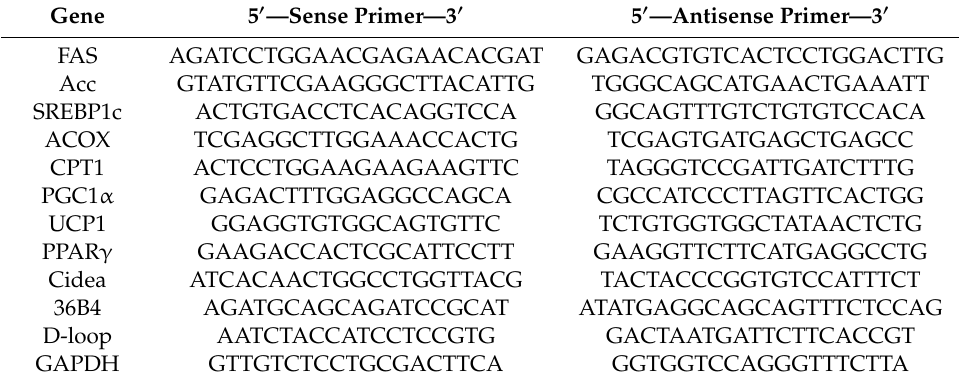
Table 1. Primers used for the Real time-quantitative PCR